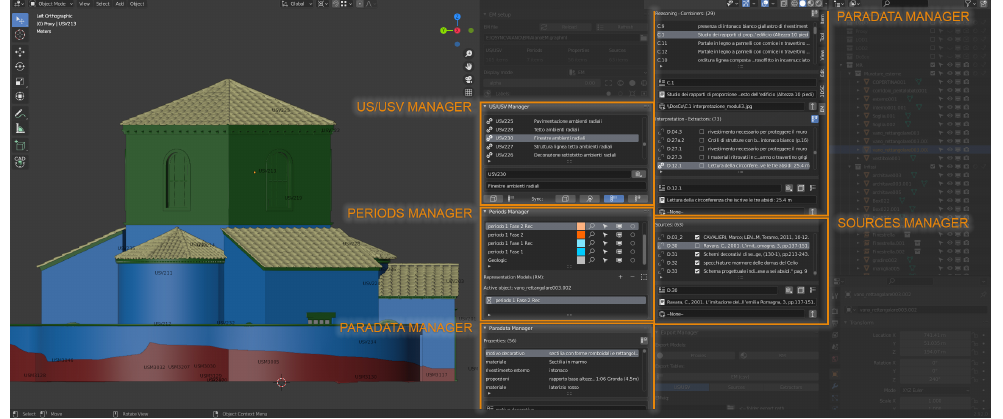
Figure 18. The layout of the EM add-on and its tools for querying semantic models after being added to the Blender